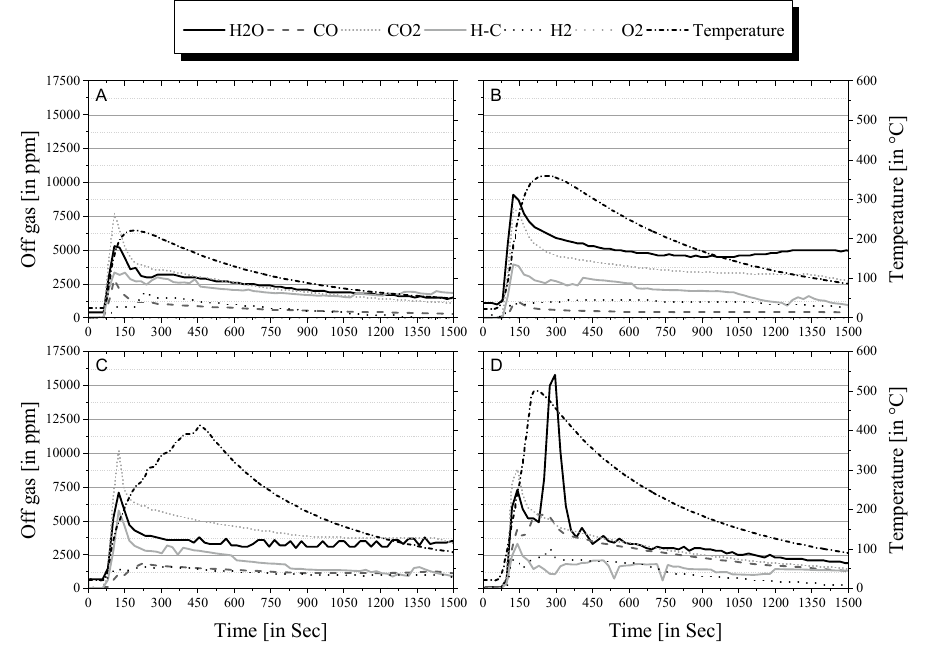
Figure 9. Produced gas analysis in microwave pyrolysis at max. temp.: ( A ) 220 °C; ( B ) 360 °C; ( C ) 418 °C; and, ( D ) 501°C.